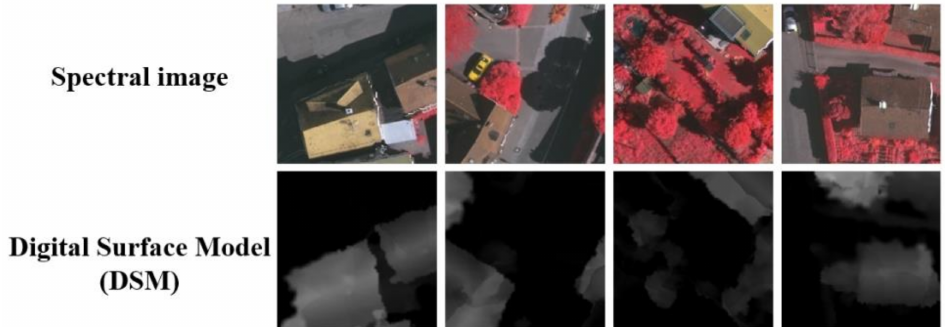
Figure 1. The top row is the spectral image of VHR remote sensing images, and the bottom row is the corresponding DSM image. The first two columns are buildings and roads in shadows. The latter two columns are trees and low vegetation with extremely similar spectral characteristics. The digital surface model avoids the interference of shadow, occlusion, and other